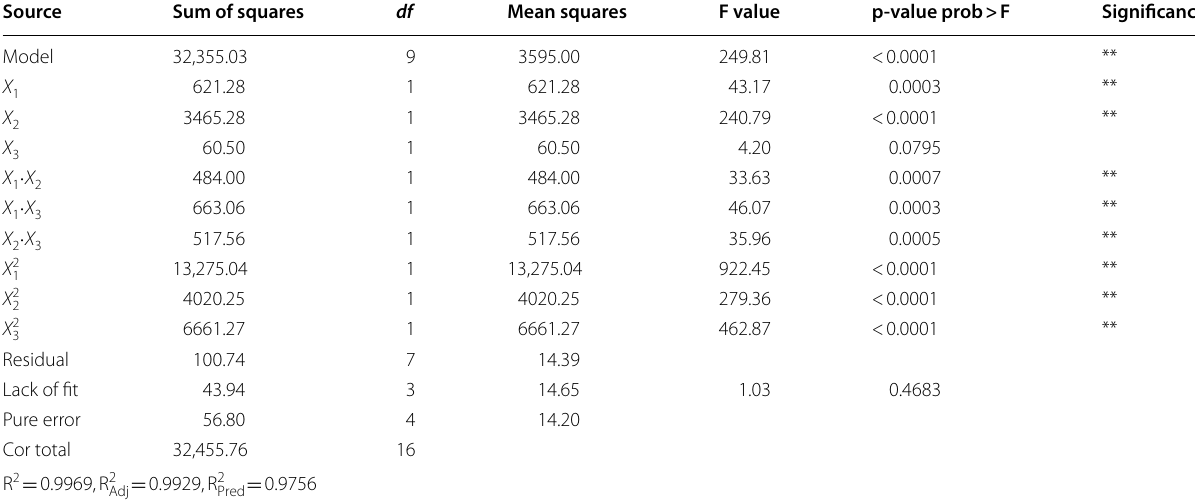
Table 6 Analysis regression and variance results